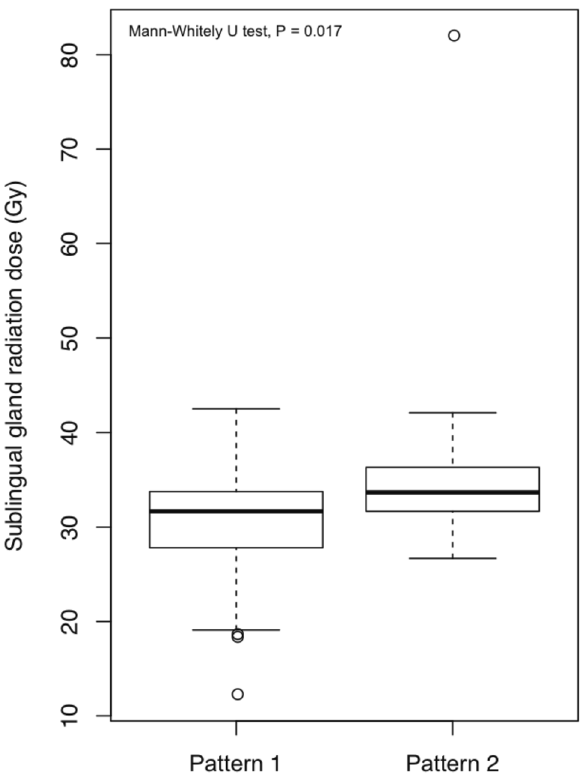
Figure 1. Radiation dose to sublingual glands in patients with oral pH patterns 1 and 2. Patients with oral pH value pattern 1 received a median dose of 31.66 Gy to the sublingual glands and patients with oral pH value pattern 2 received a median dose of 33.66 Gy ( p =